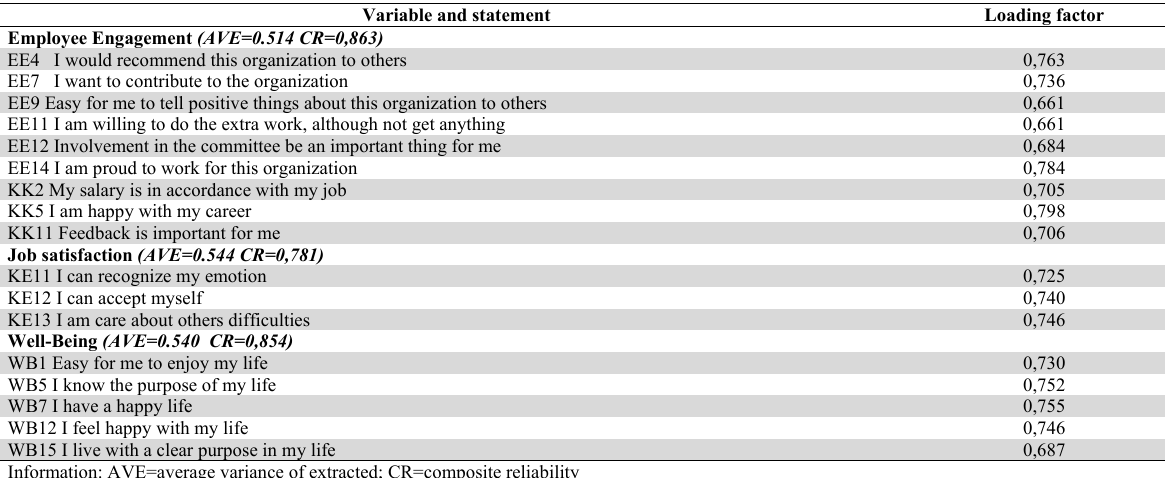
Evaluation of Measurement Model Variable and statement Loading factor Employee Engagement (AVE=0.514 CR=0,863)